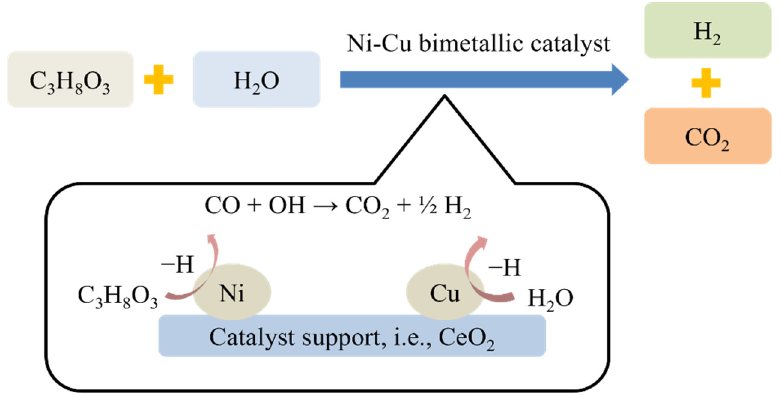
Figure 3. The underlying mechanism of Ni-Cu/CeO 2 in the steam reforming of glycerol [64]. Co, as another transition metal, has also been broadly used in the steam reforming of glycerol for H 2 production. Similar to Ni-based catalysts, Co-based catalysts also suffer from metal sintering, coke deposition, and catalyst deactivation. Dobosz et al. [68] applied Co/Ca 10 (PO 4 ) 6 (OH) 2 and Co-Ce/Ca 10 (PO 4 ) 6 (OH) 2 in glycerol steam reforming to produce H 2 , and the incorporation of CeO 2 effectively prevented Co sintering, thus leading to a relatively higher catalyst stability and H 2 selectivity than Co/Ca 10 (PO 4 ) 6 (OH) 2 . Adding Cu to the Co-based catalyst to suppress carbon deposition was investigated by Moogi et al. [40]. Based on the results from H 2 -TPR analysis, the recyclability of the Co-based catalyst was enhanced in the presence of Cu, and a shift in the reduction profile toward a lower temperature was achieved. As a comparison, 5 wt % Cu-20 wt % Co/MgO led to complete glycerol conversion and the highest H 2 yield of 74.6%, which could be due to the smaller particle size and higher surface area and metal dispersion. They found that an acceptable catalytic activity of Cu modified catalyst was attained up to 30 h of reaction by limiting carbon formation. Menezes et al. [69] synthesized Co catalysts by the wet impregnation preparation method using three different catalyst supports: Al 2 O 3 , Nb 2 O 5 , and Al 2 O 3 -Nb 2 O 5 . Their catalytic performance in the glycerol steam reforming at 500 °C for 30 h, 20 vol % of glycerol loading, and GHSV of 200,000 h − 1 was assessed. As expected, Co/Al 2 O 3 -Nb 2 O 5 was identified as the best catalyst with respect to the highest glycerol conversion of 90% and H 2 yield of 65% at 8 h of reaction; however, coke formed in all tested catalysts after 24 h of reaction. In addition to Nb 2 O 5 , the effect of the incorporation of MgO with the Co-based catalysts on the catalytic acidity, reducibility, and cobalt dispersion was also evaluated by Menezes et al. [43]. Despite the use of Co/MgO-Al 2 O 3 resulting in a higher glycerol conversion and H 2 yield, the nature of coke formed during the reaction was al- tered toward a filamentous rather than an amorphous structure. 2.2. Noble Metals Compared to transition-metal-based catalysts, the catalysts based on noble metals (e.g., Rh, Ru, Pt, and Pd) are more stable and active in the steam reforming of glycerol for producing H 2 . Together with Ni, Ru and Pt are regarded as the most promising metals in the steam reforming of glycerol for enhancing H 2 production. Until now, the catalytic ac- tivity, stability, and reducibility of Pt-based catalysts in glycerol steam reforming, such as Pt-Ni/MgAl 2 O 4 [47], Pt/CeO 2 -Al 2 O 3 [49], Pt/SiO 2 -C [50], Pt-Sn/C [52], and Pt-Mn/AC [70] have been substantially explored owing to their excellent selectivity toward C-C bond cleavage. The superior catalysts utilized in the glycerol steam reforming should meet cer- tain criteria including (i) an appropriate interaction between metal and support to ensure excellent stability and reproducibility during the reaction; (ii) high metal dispersion; and (iii) resistance to carbon deposition and sintering. Therefore, the selection of a proper sup- port that can enhance the dispersion of active metal particles and the interaction with metal plays an important role in determining catalytic performance [32]. Recently, Buffoni